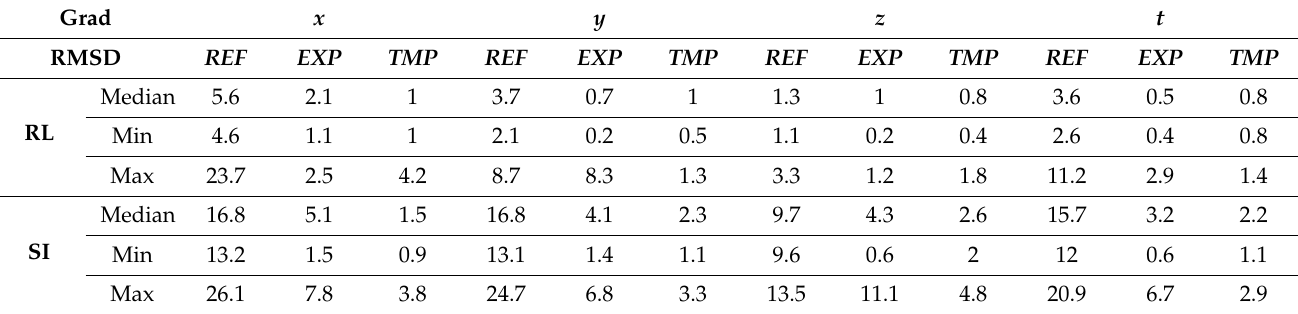
Table 2. Summary of cross-system variations (excluding Sys2) in spatial % RMSD i ( i = REF , EXP , TMP ) of gradient-channel metrics listed in Table